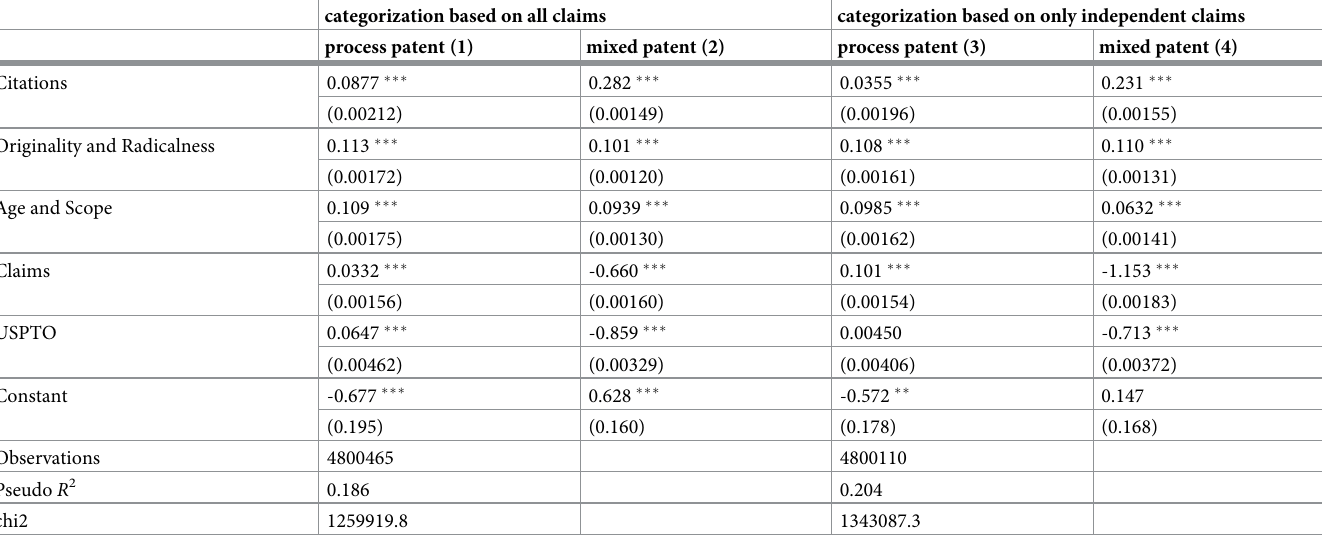
Table 5. Multinomial logit reduced model—dependent variable: Patent category, base category: product